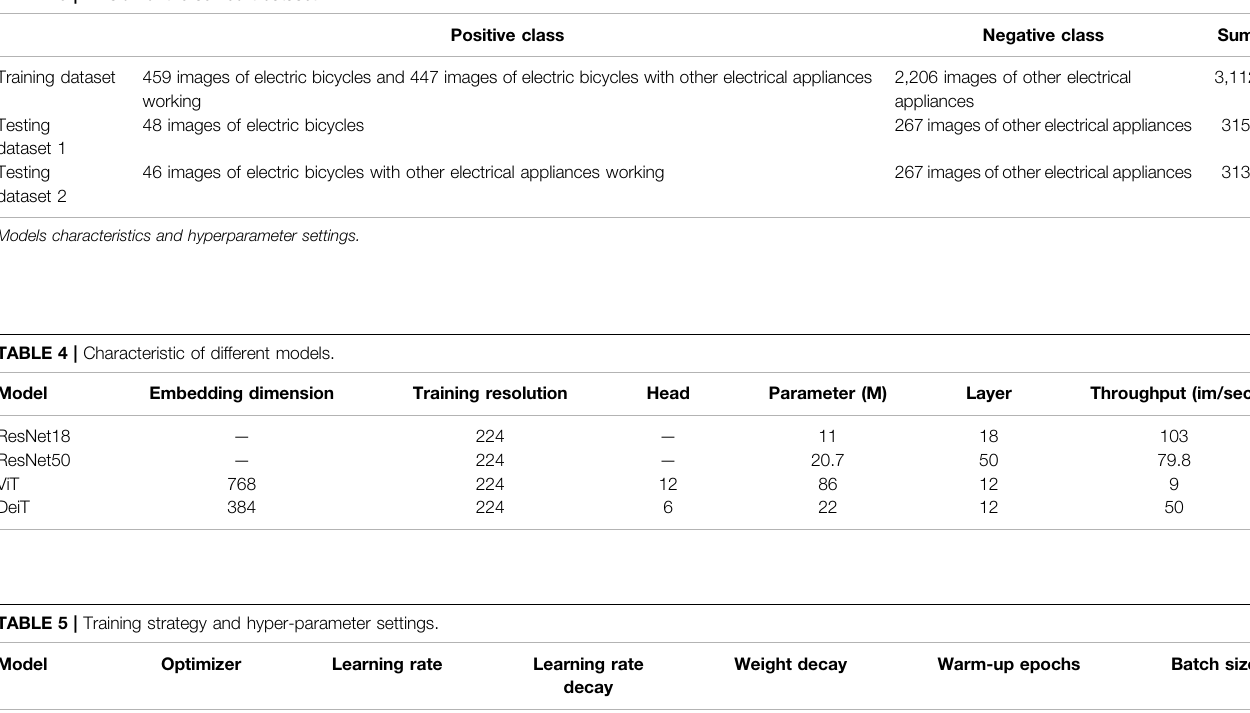
TABLE 3 | Division of the self-built dataset.